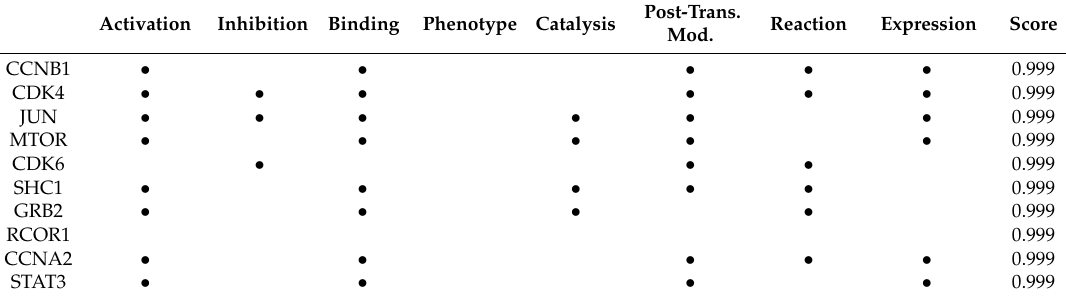
Table 2. Action view of functional targets of Tiansi Liquid obtained through STITCH. ( •